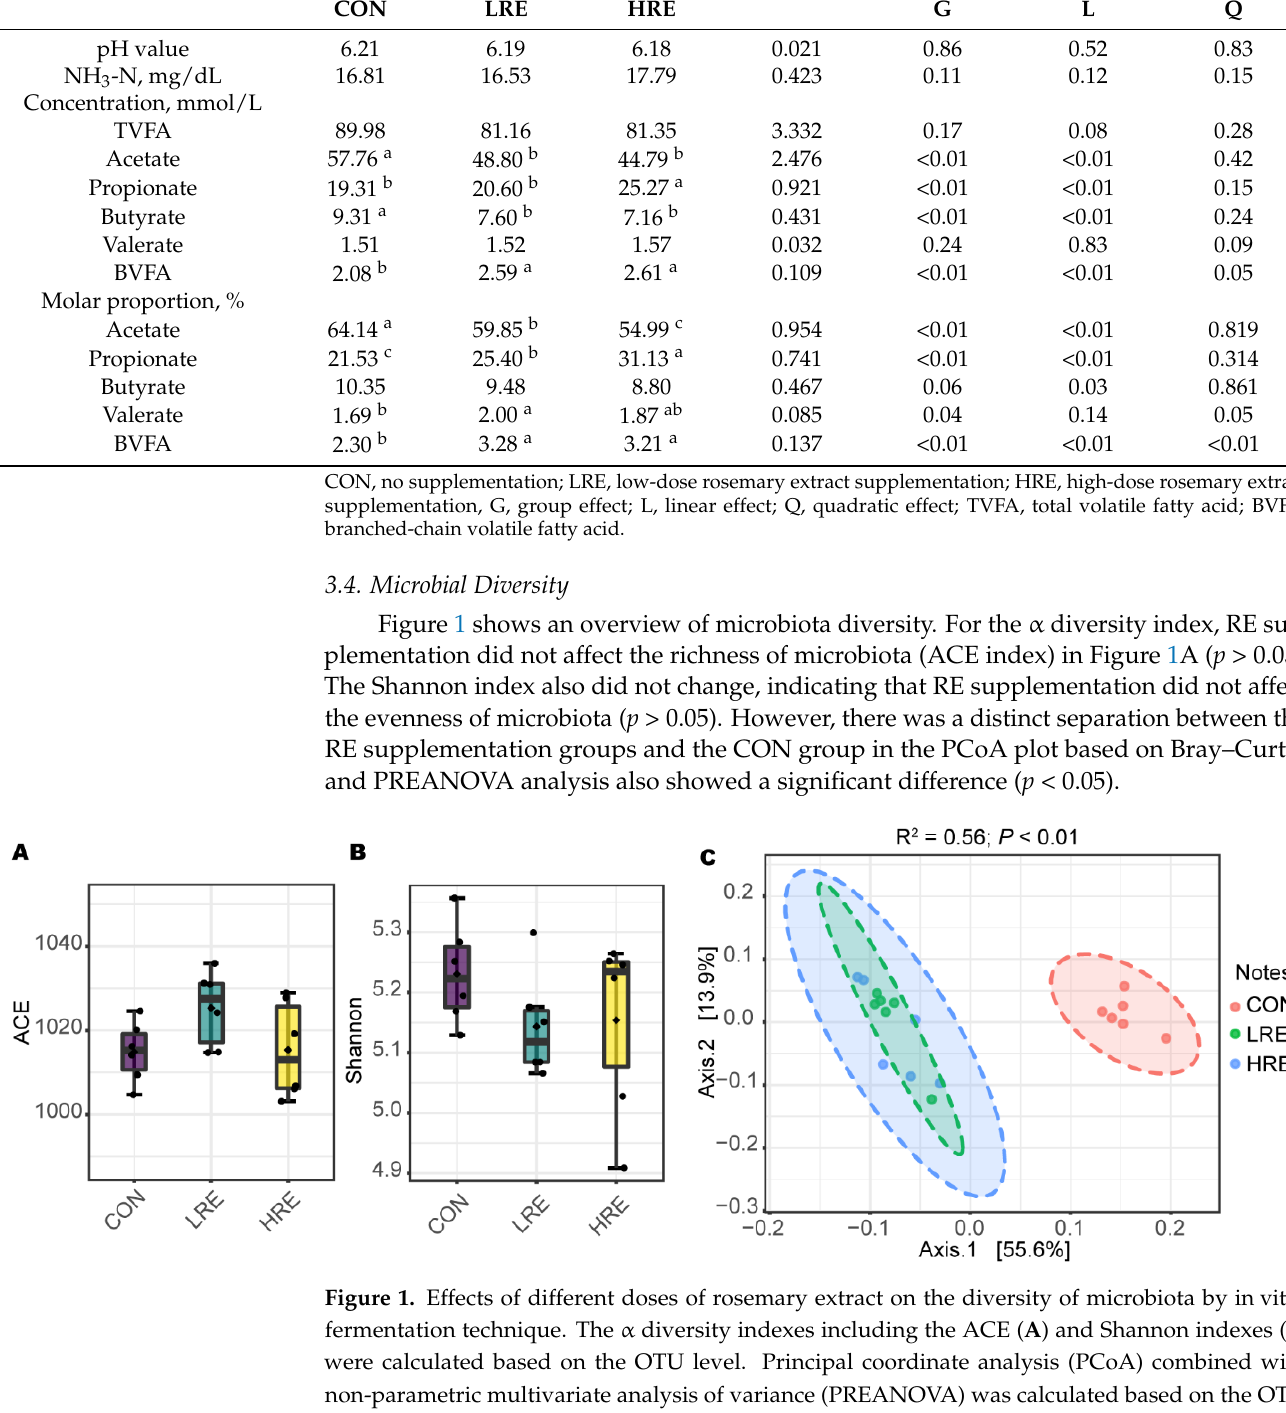
Table 4. Effects of different doses of rosemary extract on in vitro fermentation parameters.